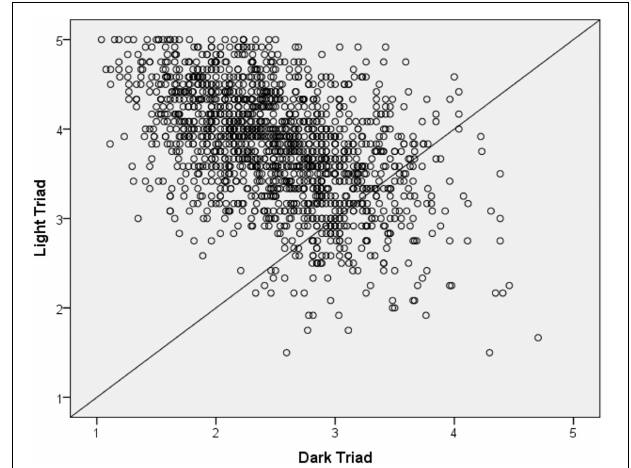
FIGURE 4 | Scatterplot of light vs. dark triad scores in the total sample. N =